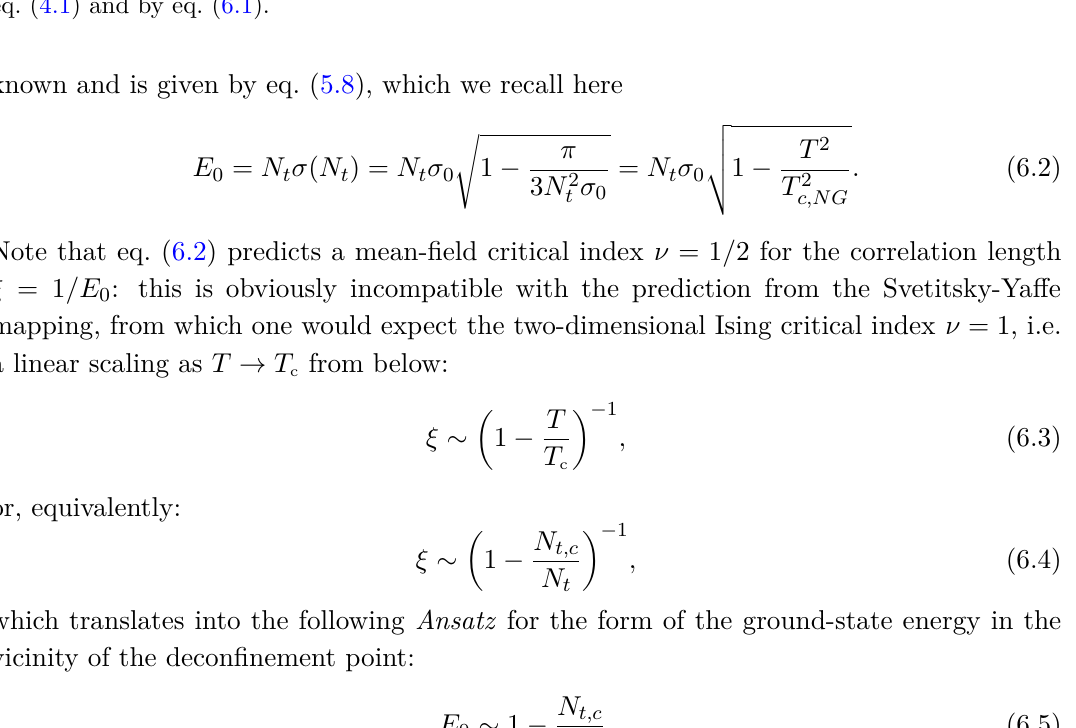
Figure 3 . Fit of the data at N t = 9 , β = 12 . 15266 , T/T and long-distance approximations of the spin-spin Ising correlator, which are respectively given by eq. (4.1) and by eq.